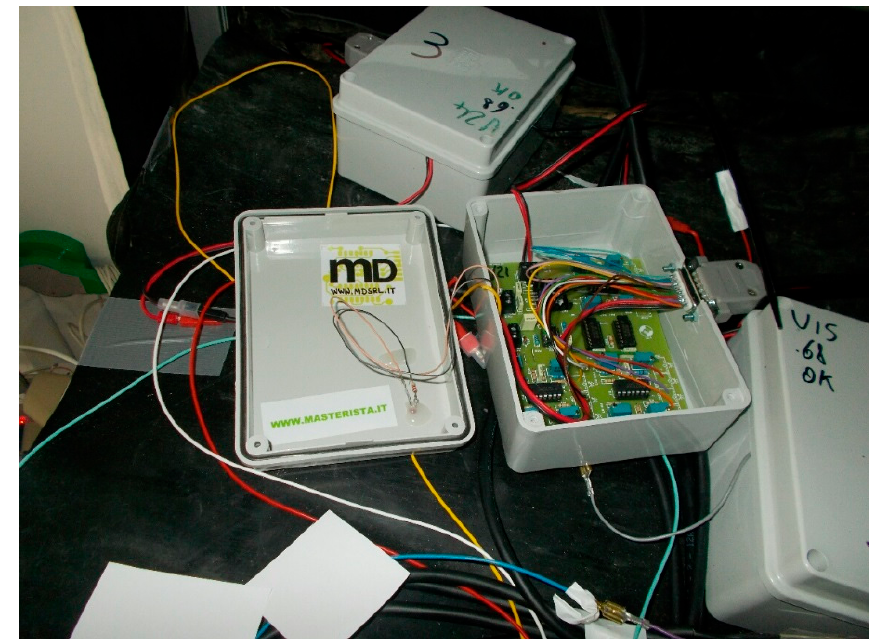
Figure 4. Signal conditioning circuit.